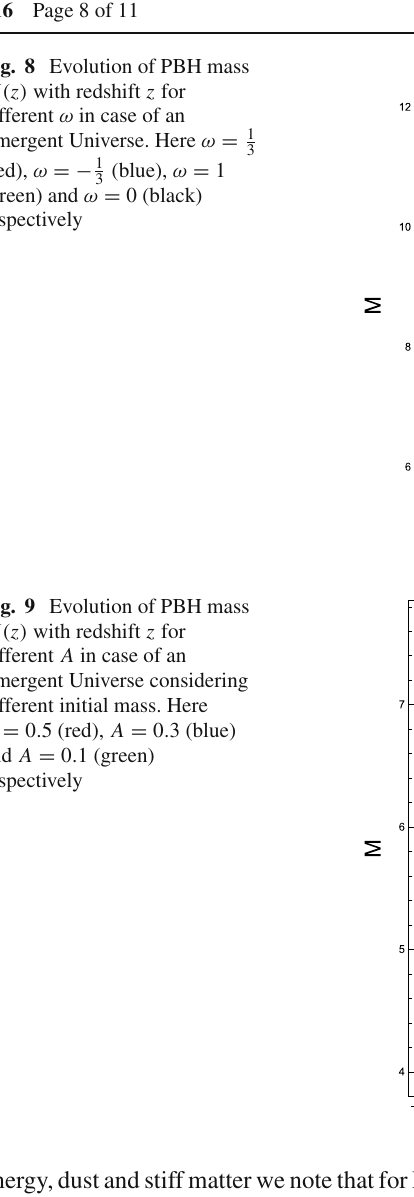
Fig. 9 Evolution of PBH mass M ( z ) with redshift z for different A in case of an Emergent Universe considering different initial mass. Here A = 0 . 5 (red), A = 0 . 3 (blue) and A = 0 . 1